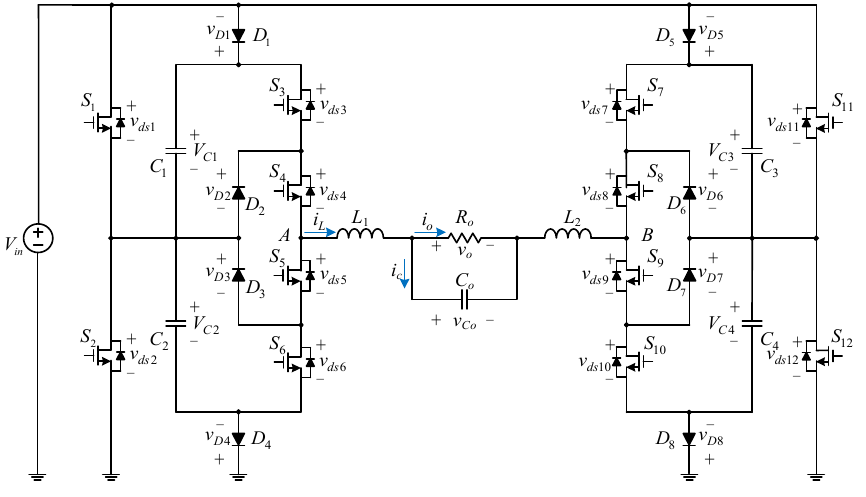
Figure 2. Single-voltage-source Class-D 7-level DC-AC converter.